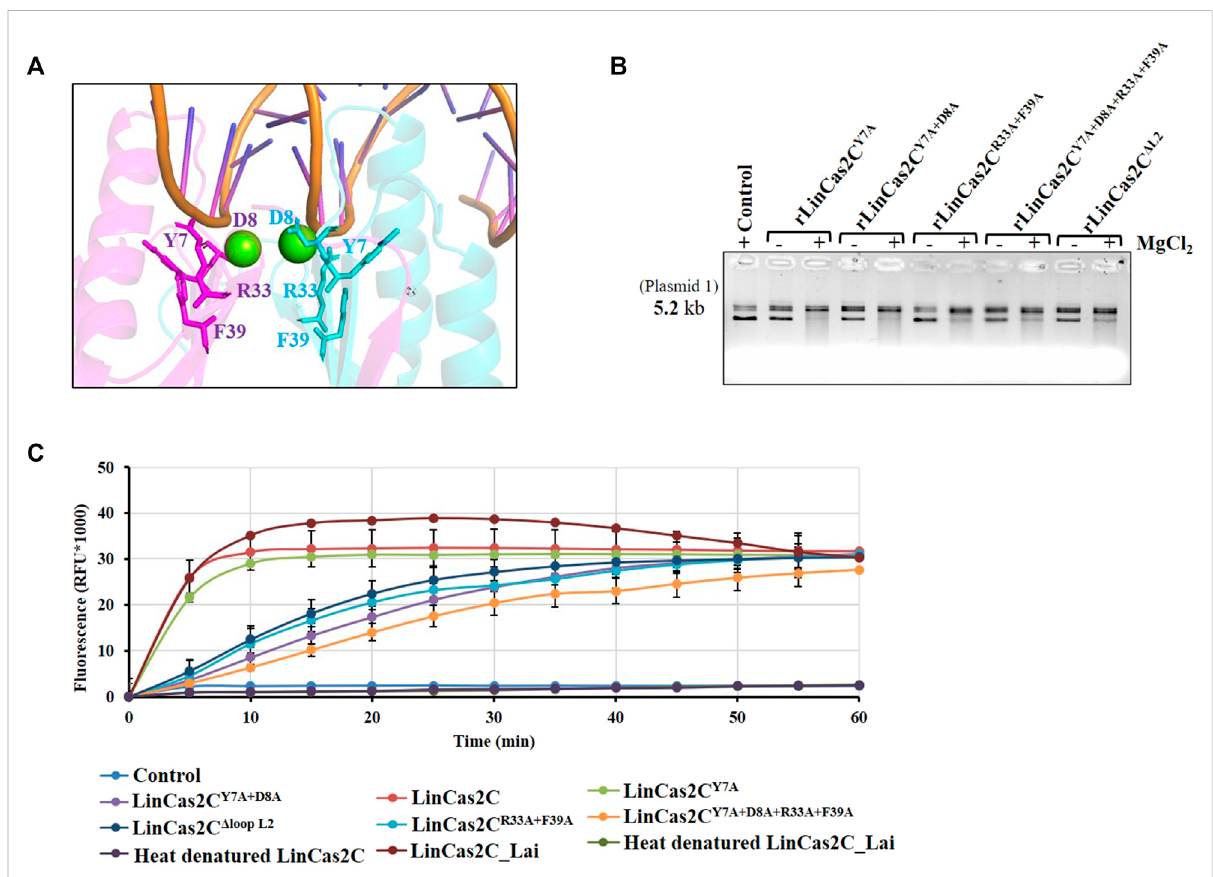
FIGURE 6 Nuclease activity of rLinCas2C mutant variants. (A) Proposed model of LinCas2C with Mg 2+ ion. LinCas2C amino acid residues interacting with metal ions and putative active site are shown in stick form. (B) Nuclease activity of rLinCas2C mutants was evaluated on plasmid-1 (0.5 µg) in the presence and absence of divalent metal ion. (C) RNase activity of rLinCas2C or its mutant variants and the rLinCas2C_Lai was quanti fi ed using fl uorescently labeled RNA substrate. A fl uorescent RNA substrate (10 pmol) was incubated with rLinCas2C or its mutants (25 µM) at 37 ° C, and fl uorescence was recorded at 5 min intervals for 1